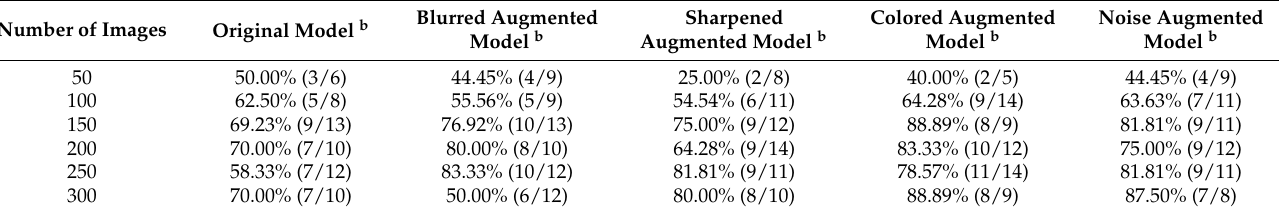
Table 5. The cross-sectional accuracy of each